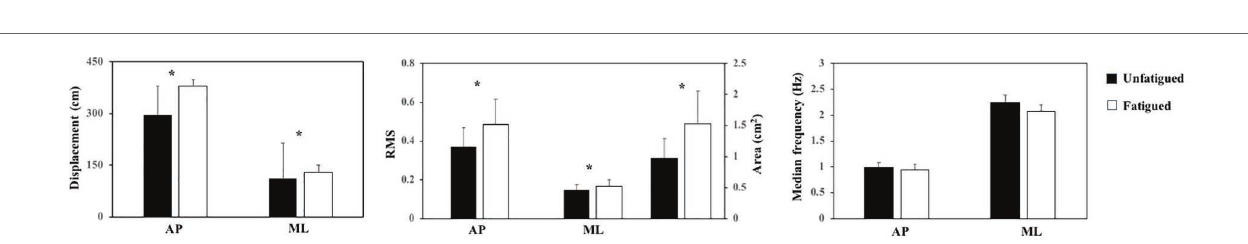
and F 1,19 = 12.99, respectively) and RMS of sway ( F 1,19 = 17.99 and F 1,19 = 9.40, respectively), as well as sway area ( F 1,19 = 36.59). Figure 4 . The vision conditions affected AP displacement ( F 2,34 = 15.04) and RMS ( F 2,34 = 15.73) of sway and area of sway ( F 2,32 = 7.03). In line with our hypothesis, SE reduced AP displacement and RMS of sway and area of sway compared to EO ( p < 0.001) and EC ( p < 0.01). However, in contrast to our hypothesis, differences between EO and EC were not significant. Vision condition also affected AP ( F 2,38 = 10.83) and ML sway frequency ( F 2,33 = 3.67). Both saccadic eye movements and closing the eyes increased the frequency of AP sway compared to the EO ( p < 0.001 and p < 0.005, respectively). ML sway frequency was higher with eyes closed than with eyes open ( p =